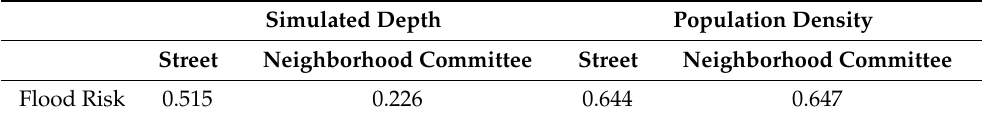
Table 2. Correlation between the flood risk and the simulated depth of water accumulation and population